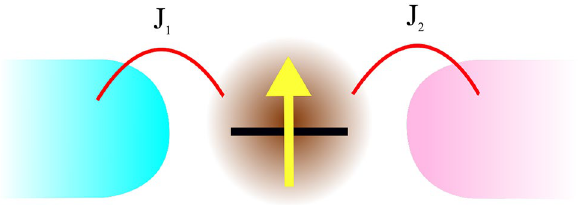
Figure 1. Schematic of a spin-1/2 magnetic impurity coupled to two screening channels via effective exchange interaction J α , where α = 1 ( α = 2 ) for the first (second)